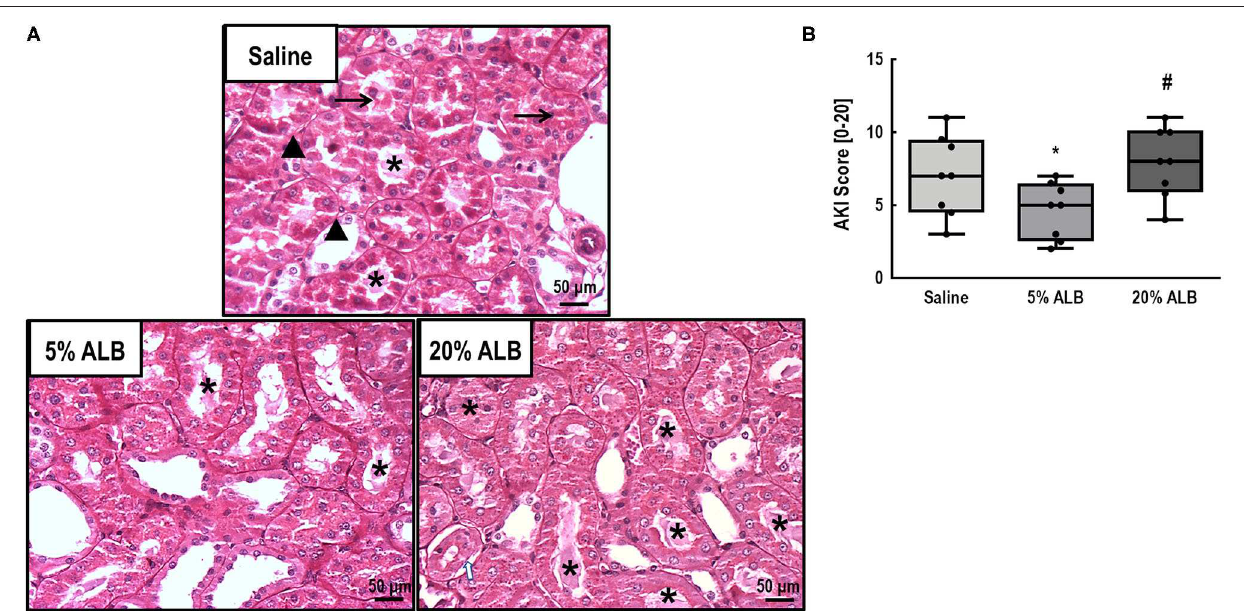
FIGURE 4 | Acute kidney injury (AKI) score (absence of brush border, presence of vacuolization, desquamation, cell debris, and hyaline casts). (A) : Representative photomicrographs (light microscopy) of kidney tubules stained with periodic acid–Schiff reagent (PAS). Absence/derangement of the brush border in proximal tubular epithelia ( N ), tubular cell vacuolization ( → ), and tubular obstruction due to the presence of cellular debris or casts (*) in kidney histological sections of 6–8 animals (original magnification, × 200). (B) : AKI score. Data are shown as median [interquartile range]. Comparisons among all groups were done using the Kruskal–Wallis test followed by Dunn’s post hoc test. Five percentage ALB: 5% albumin; 20% ALB: 20% albumin. * vs. Saline; # vs. 5% ALB. For all comparisons, significance accepted at p < 0.05.